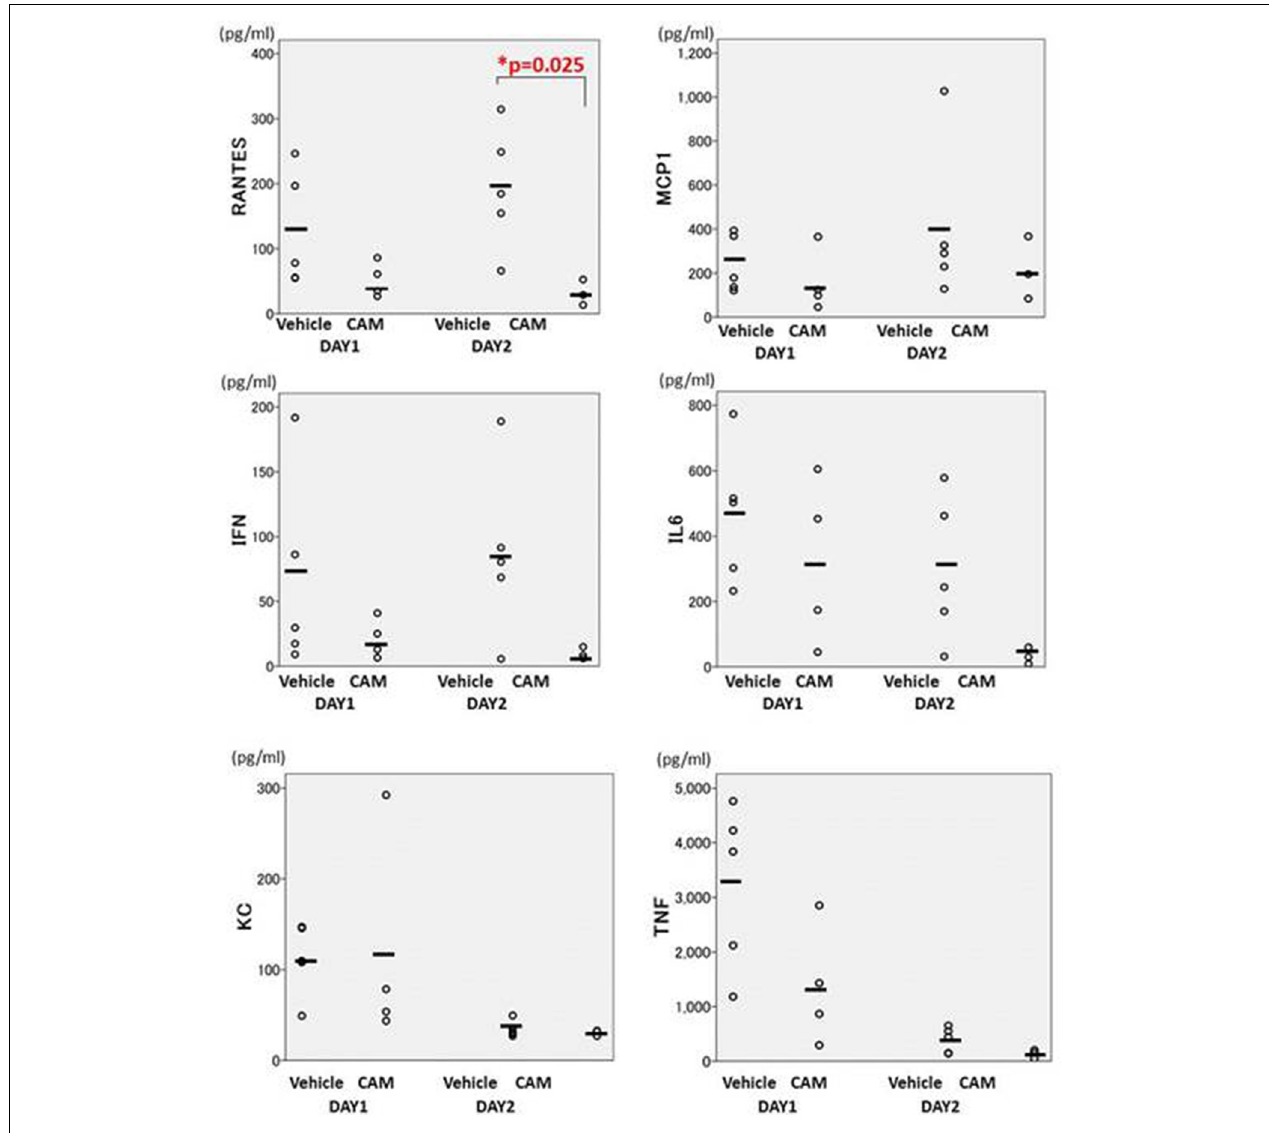
FIGURE 12 | There were fewer cytokines in the CAM50-treated group (50mg/kg/day orally), compared with the vehicle group. Only RANTES was significantly suppressed in the